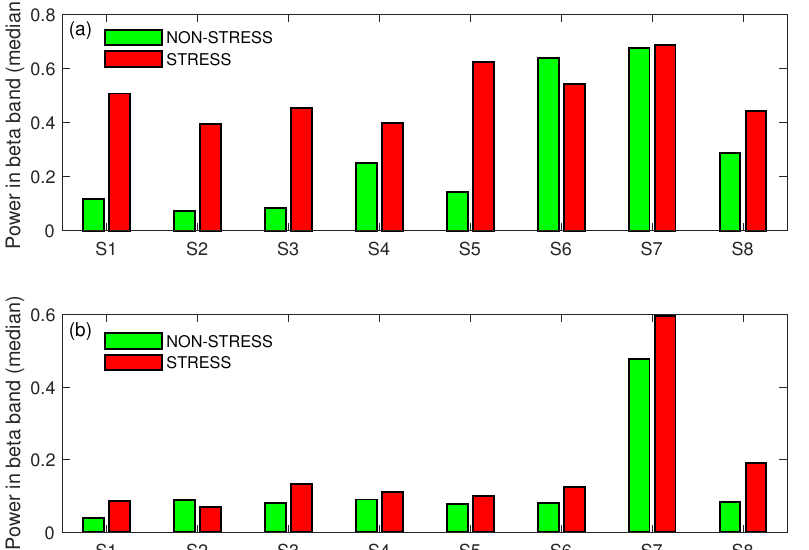
Figure 6. STRESS vs. NON-STRESS condition—difference in medians across subjects for Task A ( a ), and Task B ( b ); S: